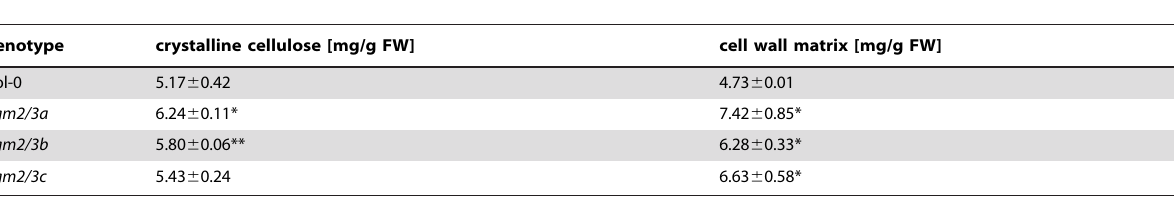
Table 2. Amount of crystalline cellulose and of cell wall matrix in Col-0 and pgm2/3 .